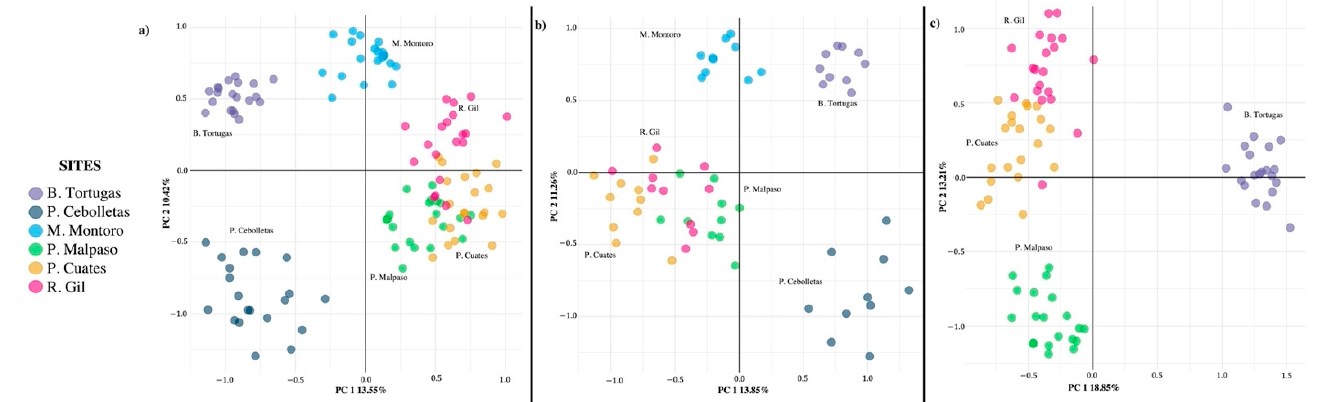
Figure 4. Principal component analysis of Pachyphytum caesium populations without simulation ( a ); with simulation of the extraction of individuals ( b ); and the local extinction of two populations ( c ).